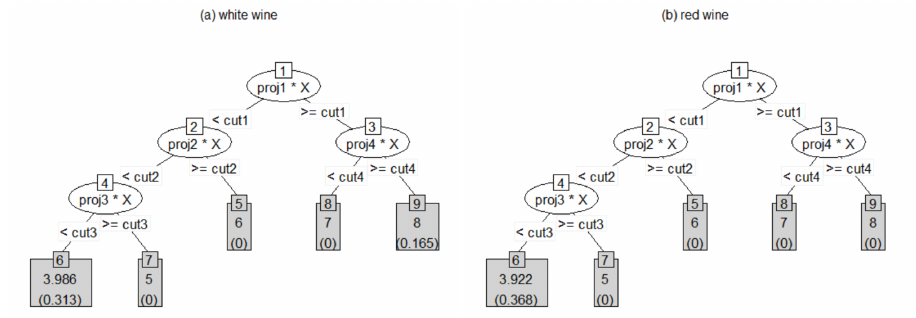
Figure 7. The projection pursuit regression tree for the wine data: ( a ) white wine and ( b ) red